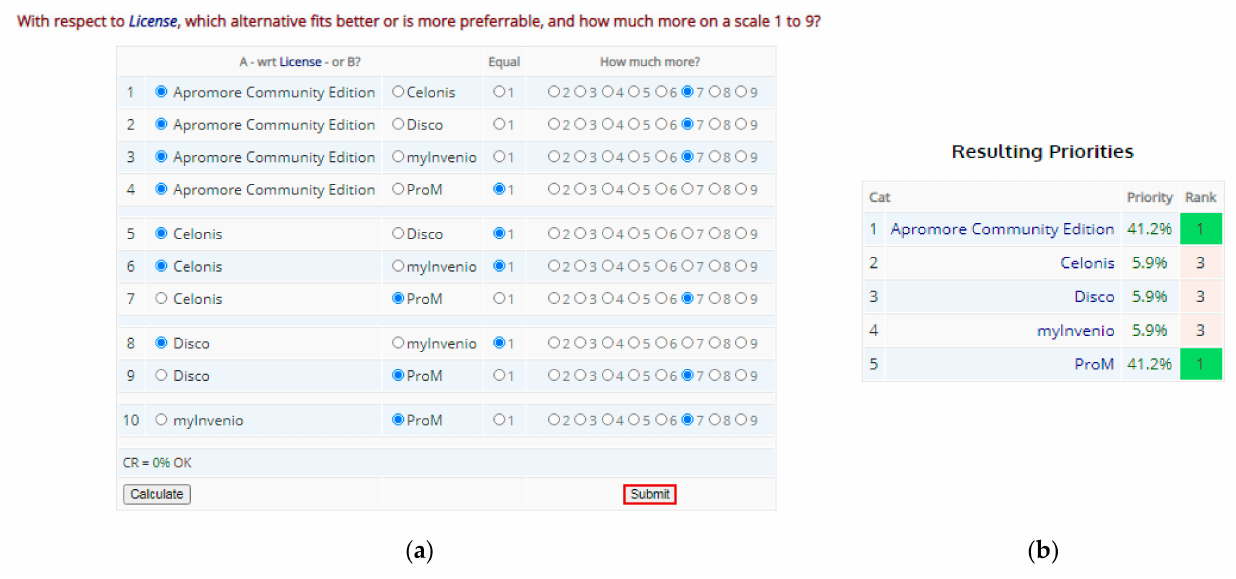
Figure 8. ( a ) Pairwise comparisons of all the alternatives for License [32,35]; ( b ) resulting priorities of the alternatives